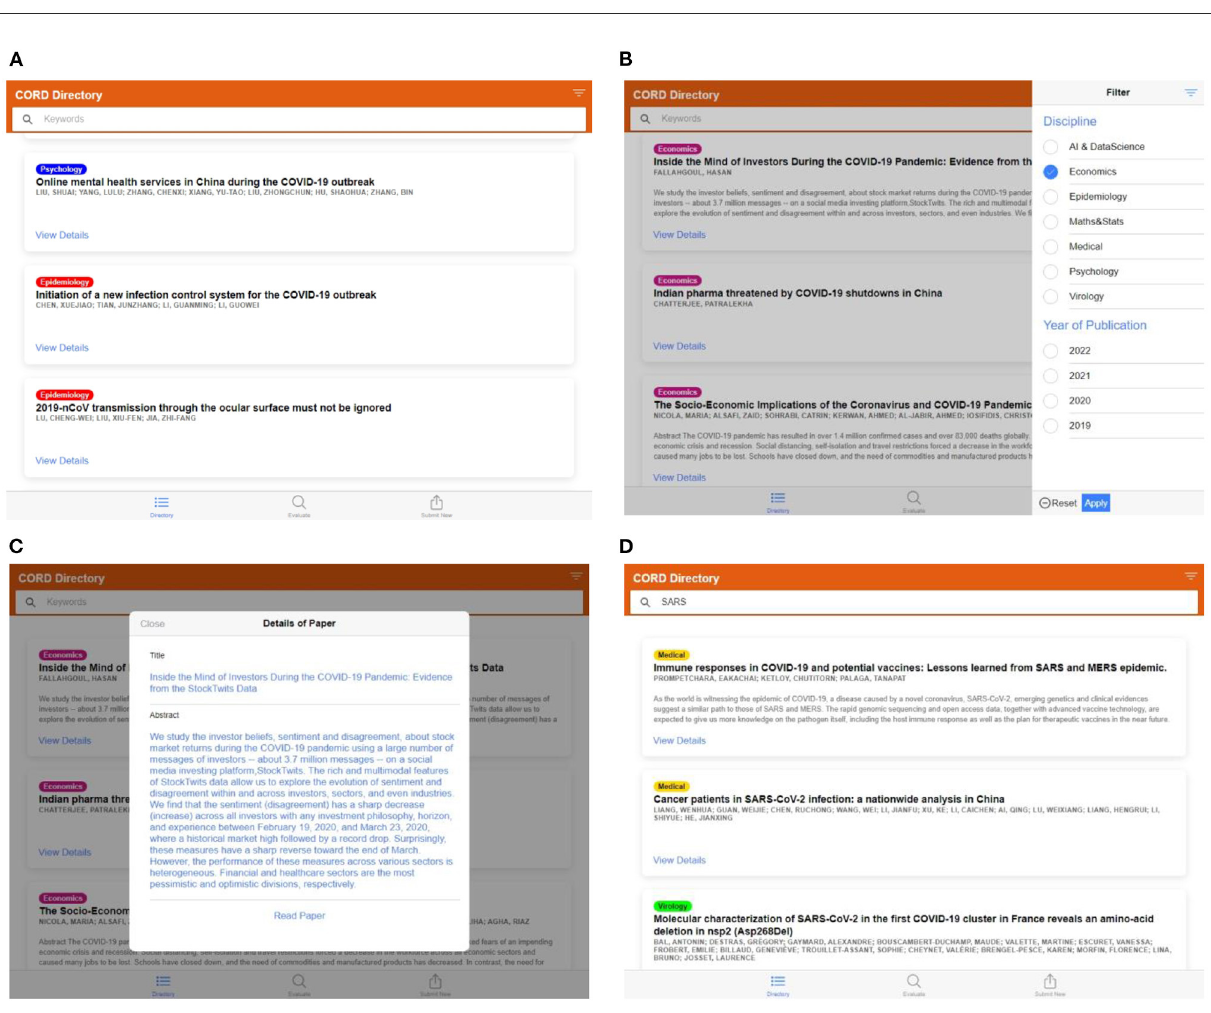
FIGURE10 (A) Screen capture of the “Directory” tab—list of labeled articles in the database, (B) filter panel on the left side to select the articles of the particular category, (C) details of the listed articles, read paper tab will redirect to the original article page through DOI, (D) keyword tab can be used to search the article from the labeled